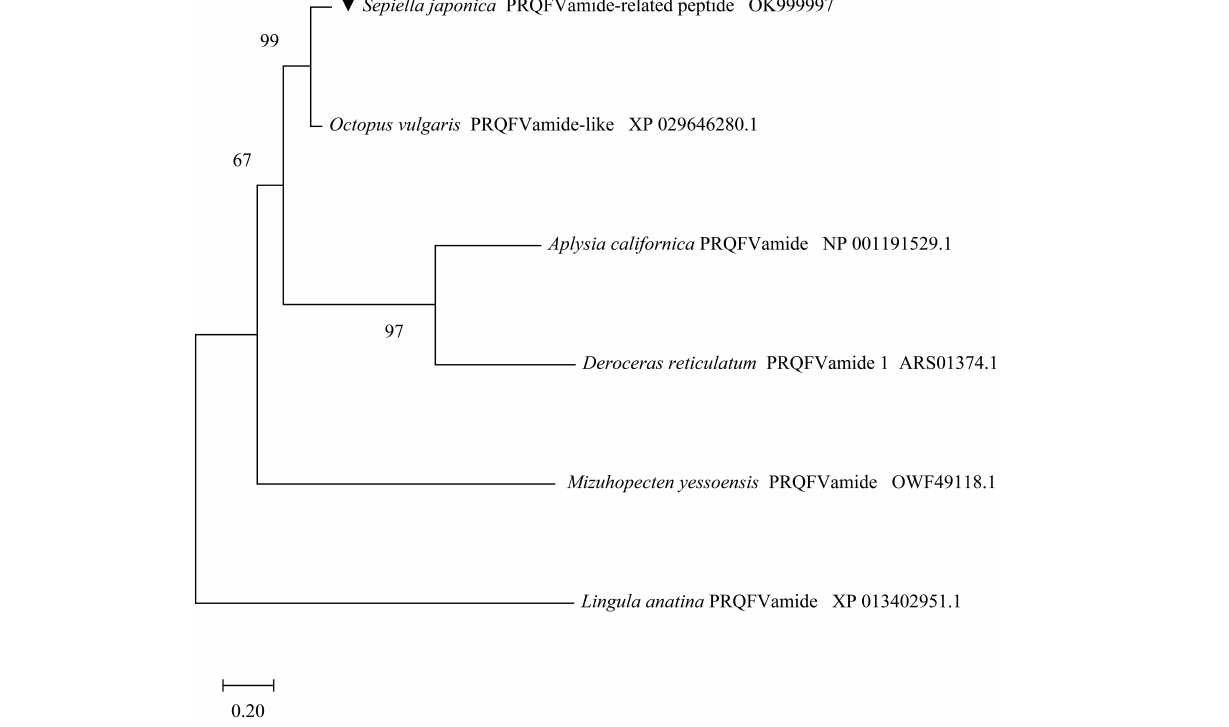
FIGURE 3 | Phylogenetic tree of Sj PRQFVRP with five other PRQFVamide using the maximum likelihood method. The Sj PRQFVRP is noted by (cid:72) . All protein sequences are obtained from GenBank of the NCBI, and the GenBank accession numbers are as follows: Sepiella japonica (OK999997), Octopus vulgaris (XP 029646280.1), Mizuhopecten yessoensis (OWF49118.1), Aplysia californica (NP 001191529.1), Deroceras reticulatum (ARS01374.1), and Lingula anatina (XP 013402951.1). The PRQFVamide of L. anatina serves as the outgroup. The topological stability of the tree is achieved by running 1,000 bootstrap replications. Bootstrap values (%) are indicated by numbers at the